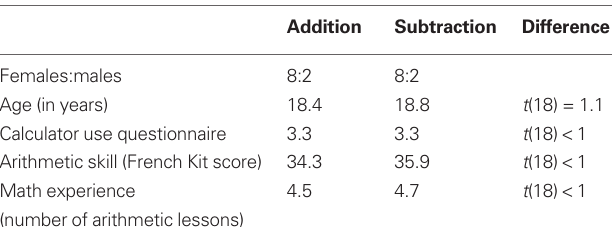
Table 1 | Participant information for the addition group ( N = 10) and the subtraction group ( N =